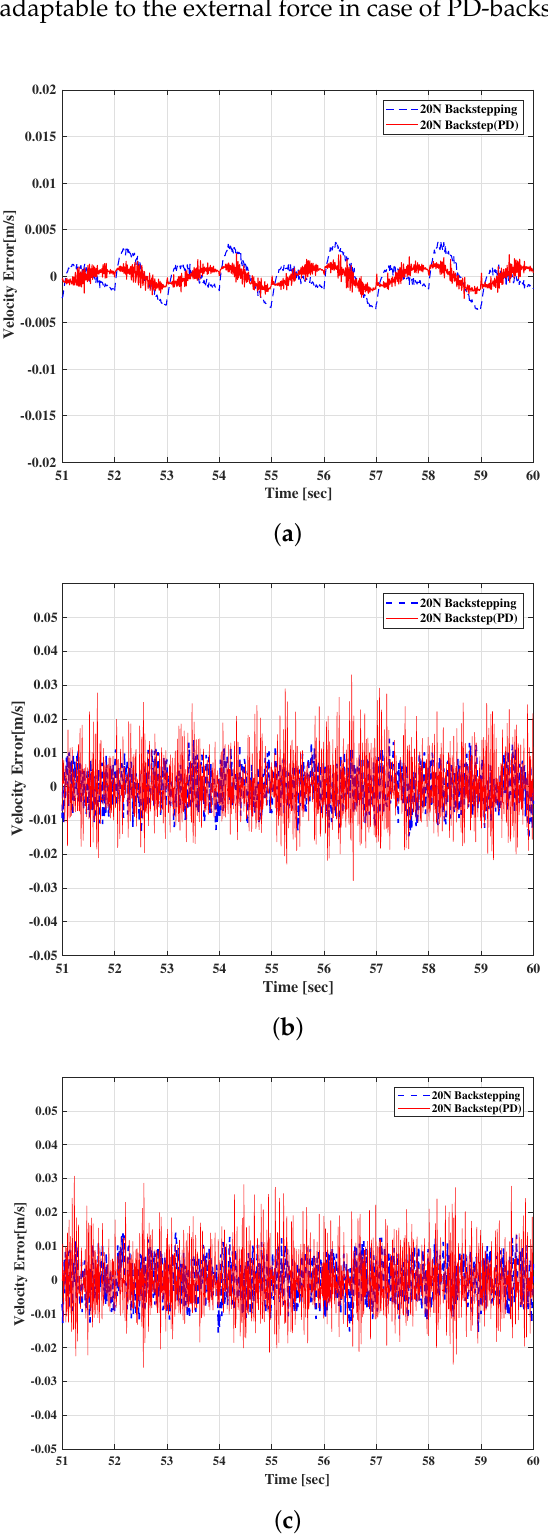
Figure 12. Velocity errors with reciprocal motion of the upper arm. ( a ) Period = 2.0 s; ( b ) Period = 1.5 s; ( c ) Period = 1.0